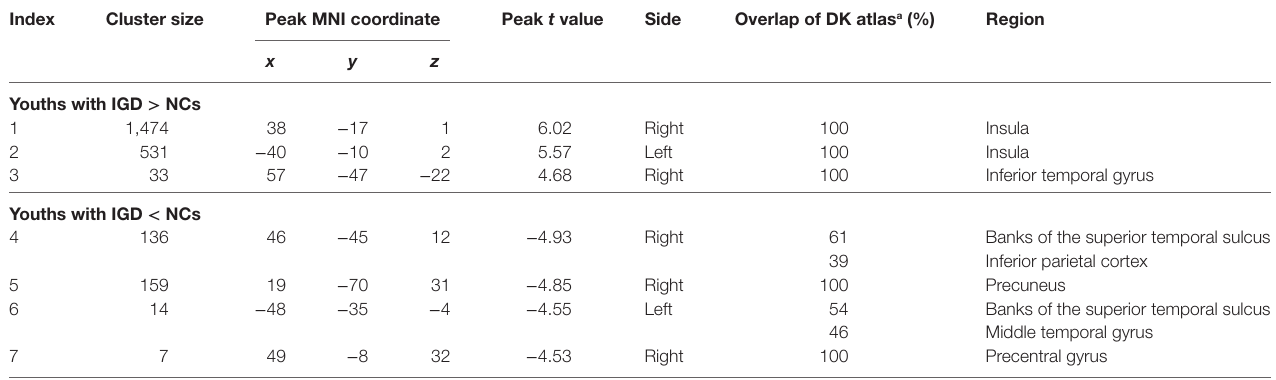
TaBle 2 | Brain regions showing group differences in